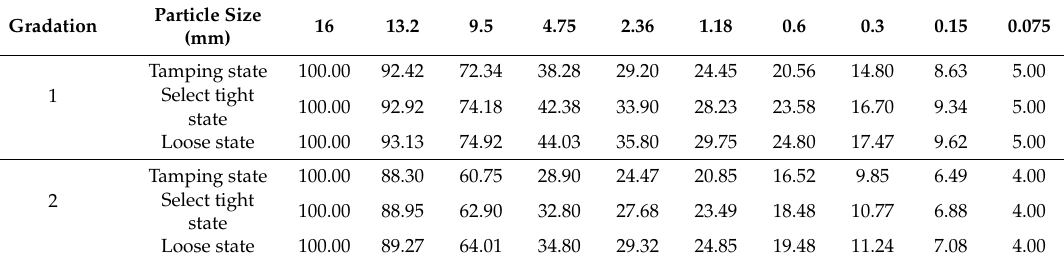
Table 10. Gradation under di ff erent filling